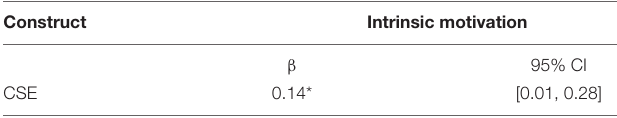
TABLE 4 | Indirect effect